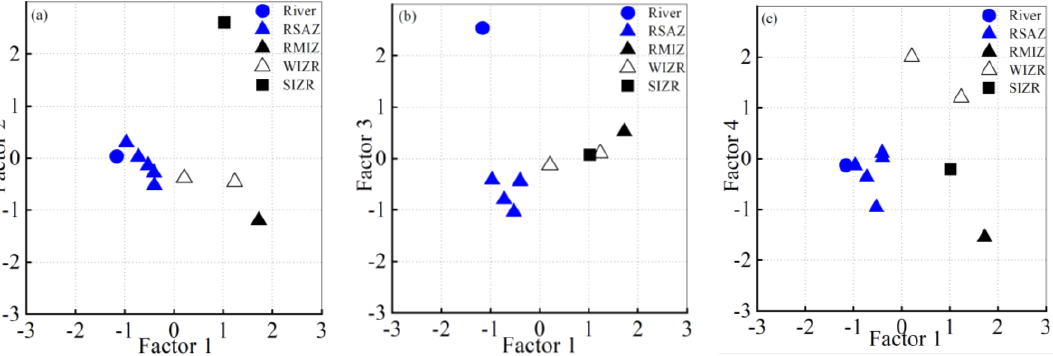
Figure 6. Plots of four factor scores showing the distribution of HCA-derived clusters: ( a ) factor 1 vs. factor 2; ( b ) factor 1 vs. factor 2; and ( c ) factor 1 vs. factor 3.